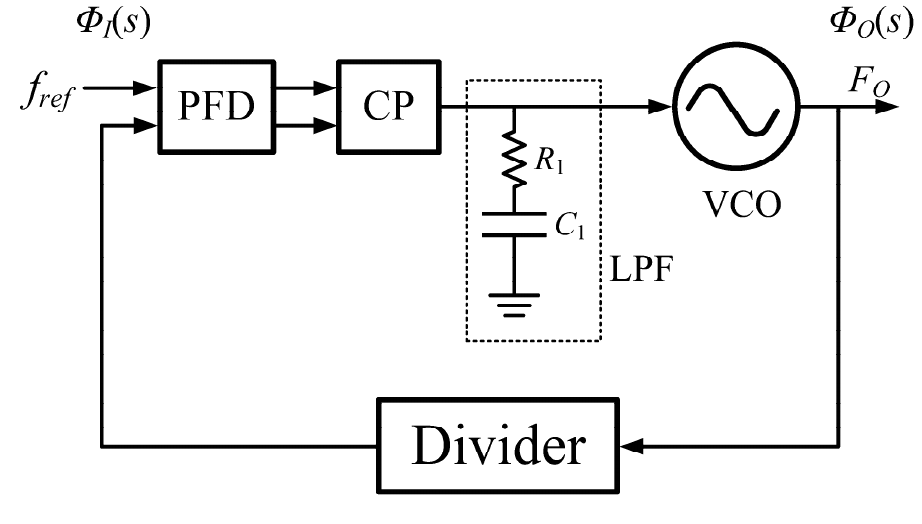
Figure 1. Traditional PLL block diagram.